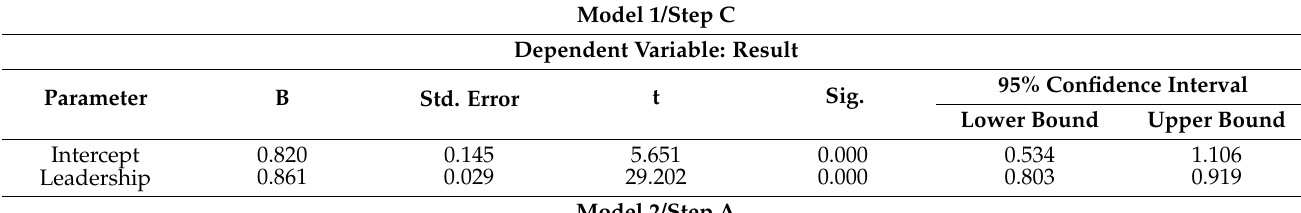
Table 5. Parameter Estimates. Source: authors’